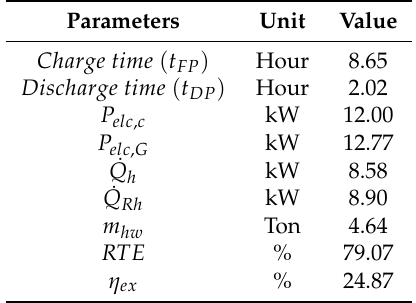
Table 8. Results of thermodynamic simulation.